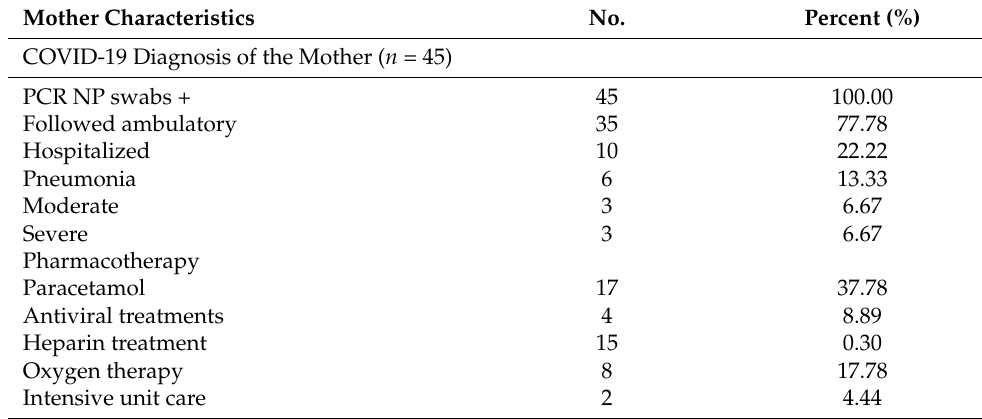
Table 3. Diagnosis and outcomes of pregnant women with coronavirus disease